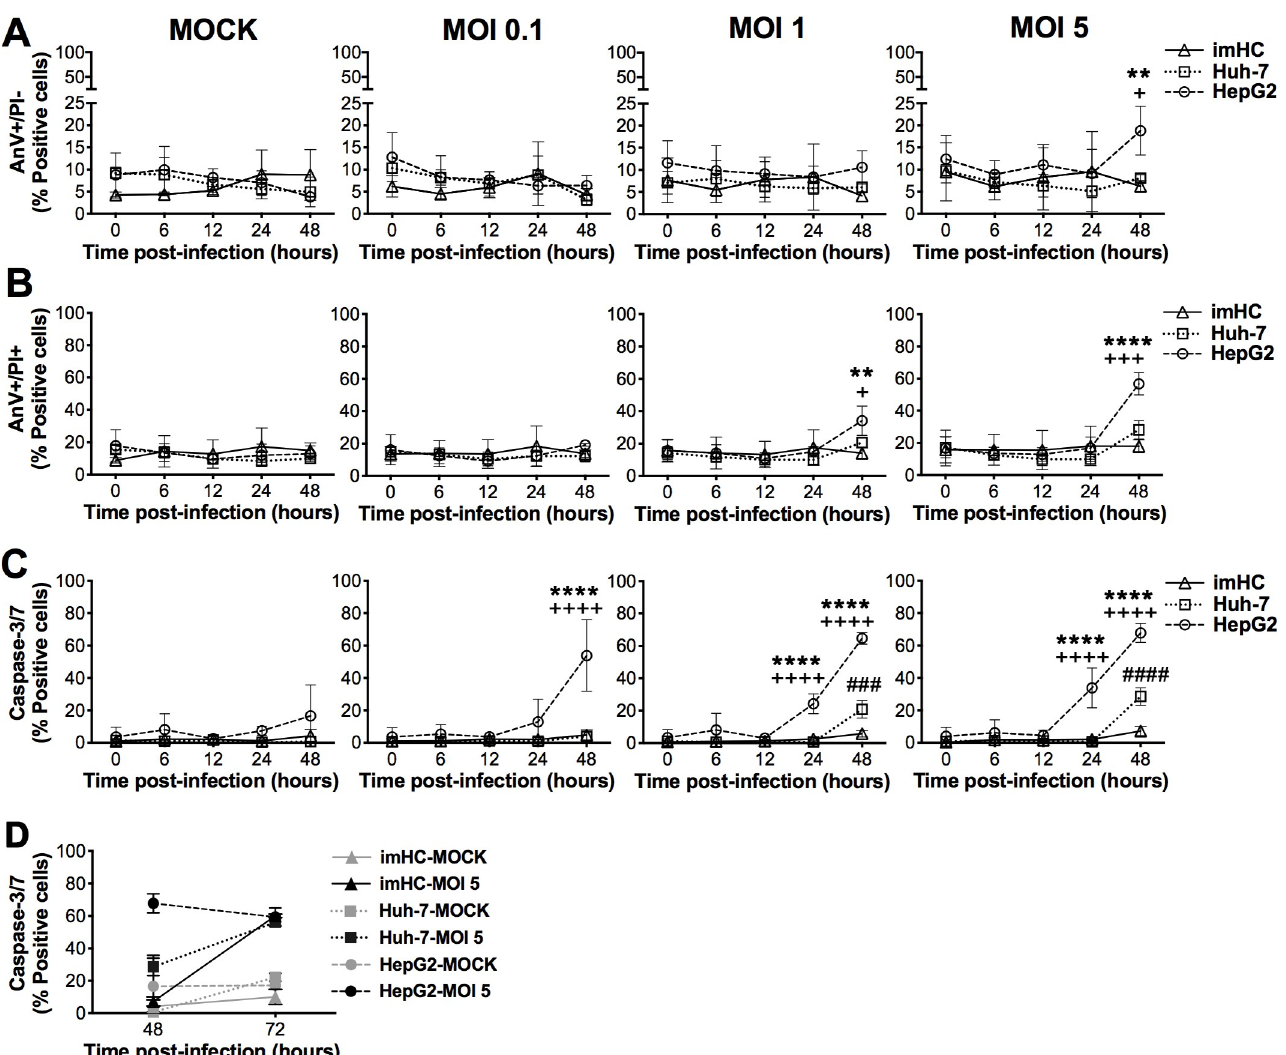
Fig 4. Viability of imHC and the hepatoma cell lines over the time course of DENV-2 infection. The cells were cultured in 24-well plates and mock-infected or infected with different MOIs of DENV-2 (0.1, 1 and 5), and then assessed for their viability at the indicated time points post-infection. ( A ) Graphs showing percentages of cells that had positive staining for annexin V but negative staining for propidium iodide (AnV+/PI-) (early apoptotic cells). ( B ) Graphs showing percentages of cells that were positively stained for both AnV and PI (AnV+/PI+) (late apoptotic cells). ( C-D ) Graphs showing percentages of apoptotic cells with positive staining for caspase-3/7 activation. All data are presented as mean ± S.D. of values from three independent experiments. An asterisk ( � ), “ # ” symbol and “ + ” symbol indicate significant differences between imHC vs HepG2, imHC vs Huh-7, and Huh-7 vs HepG2, respectively ( � P < 0.05; �� P < 0.01; ���� P <